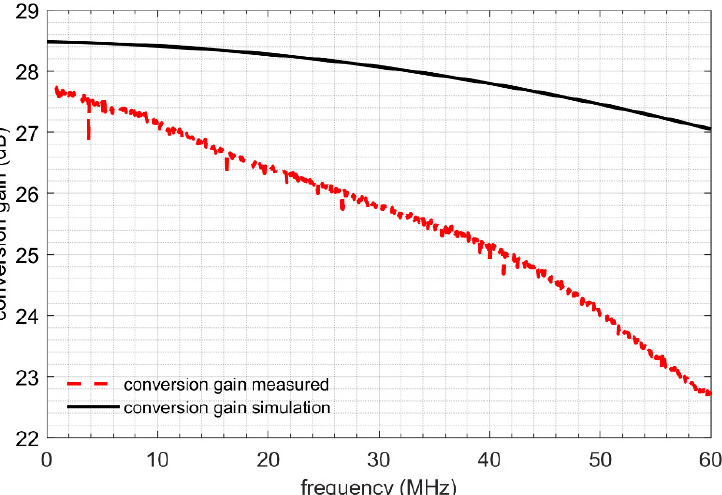
Figure 21. Comparison of measured and simulated noise figure—balun and mixer.